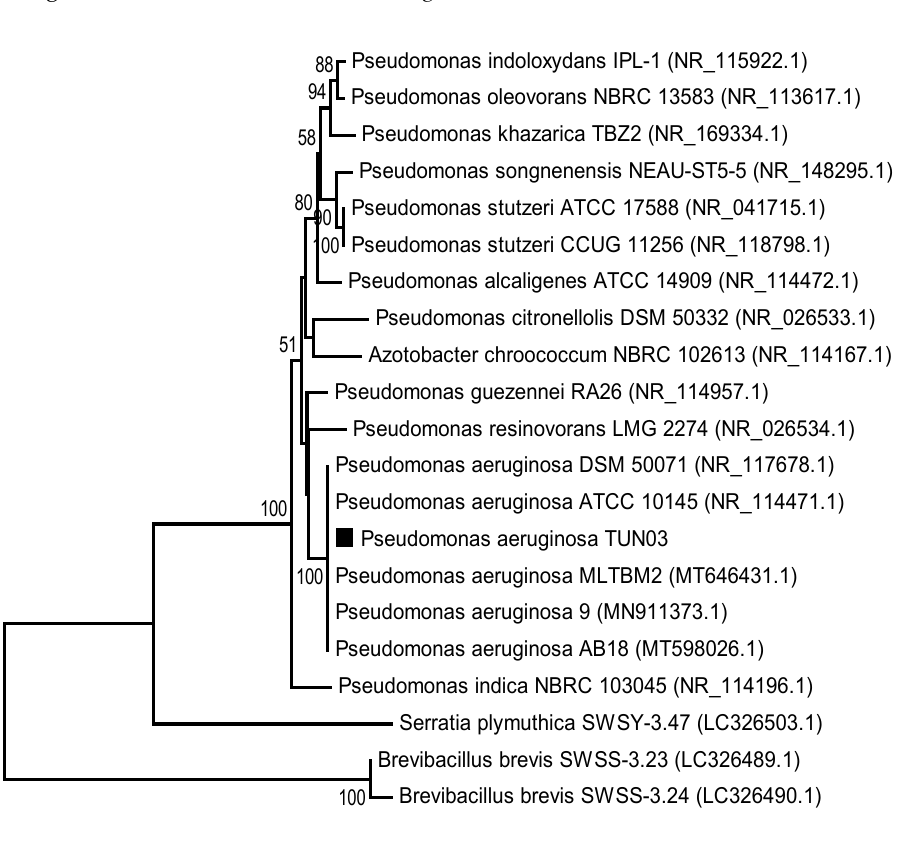
Figure 3. Phylogenetic analysis of the rhizobacterium Pseudomonas aeruginosa TUN03 based on the 16s rRNA gene sequences. The phylogenetic tree was constructed using Kimura’s method and Mega software version 6.0 after multiple alignments of the data by ClustalW. The numbers at the branches are bootstrap confidence percentages (%).